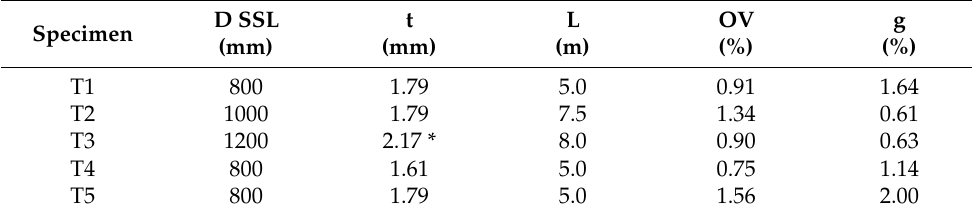
Table 1. Measured geometric dimension of lined pipe